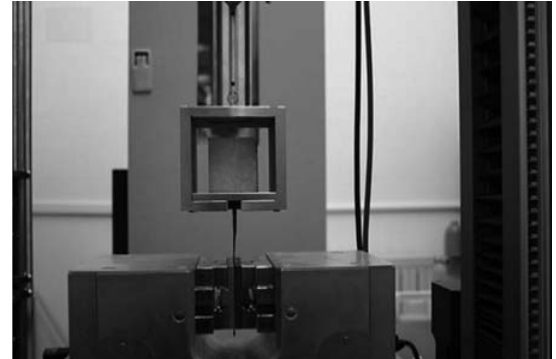
Figure 2 The pull-out setup.